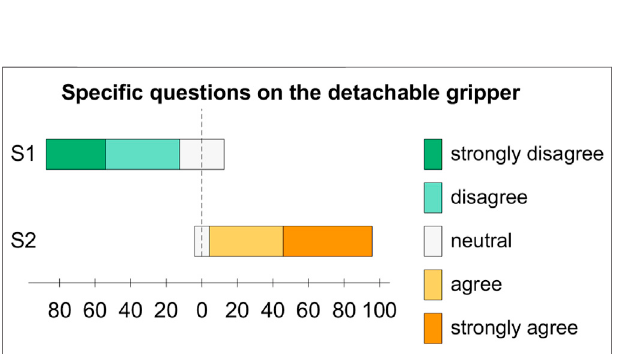
FIGURE 10 | Answers of the 12 users to the speci fi c questions on the system reported in Table 2 .